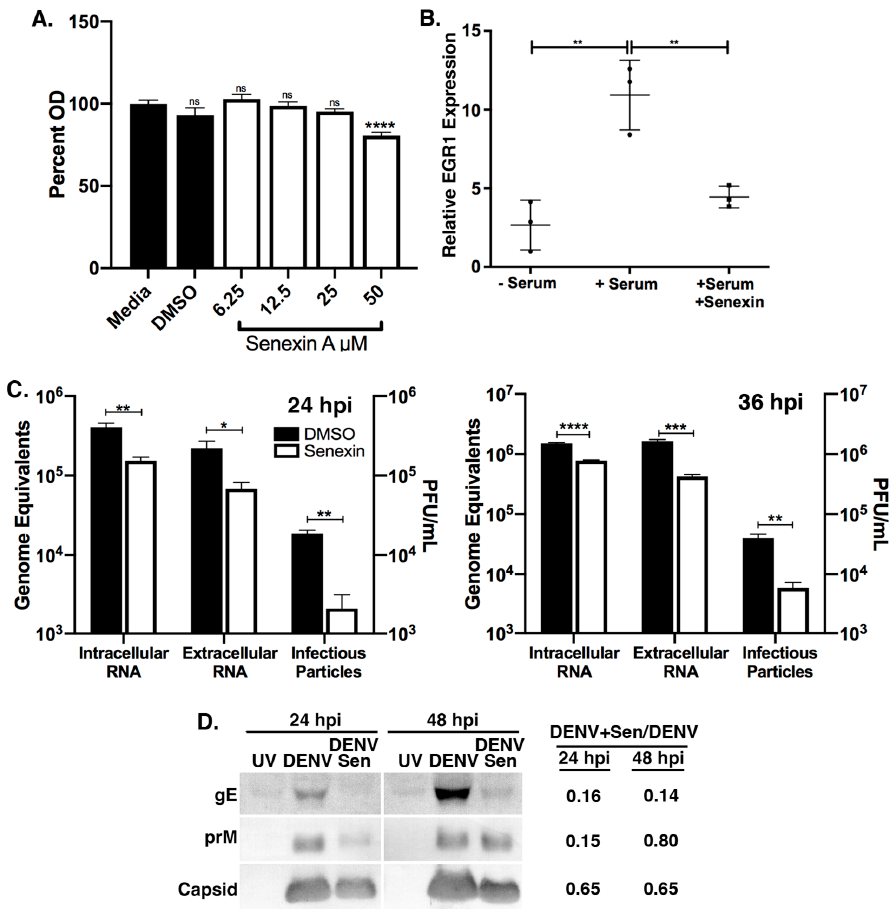
Figure 3. CDK8/19 Chemical inhibition reduces DENV2 replication. ( A ) Relative optical density of Huh7 cells after 72 h treatment with DMSO or Senexin A at indicated doses and addition of CellTiter 96 Error bars represent mean +/ SEM). ( B ) EGR 1 mRNA levels in serum-starved and